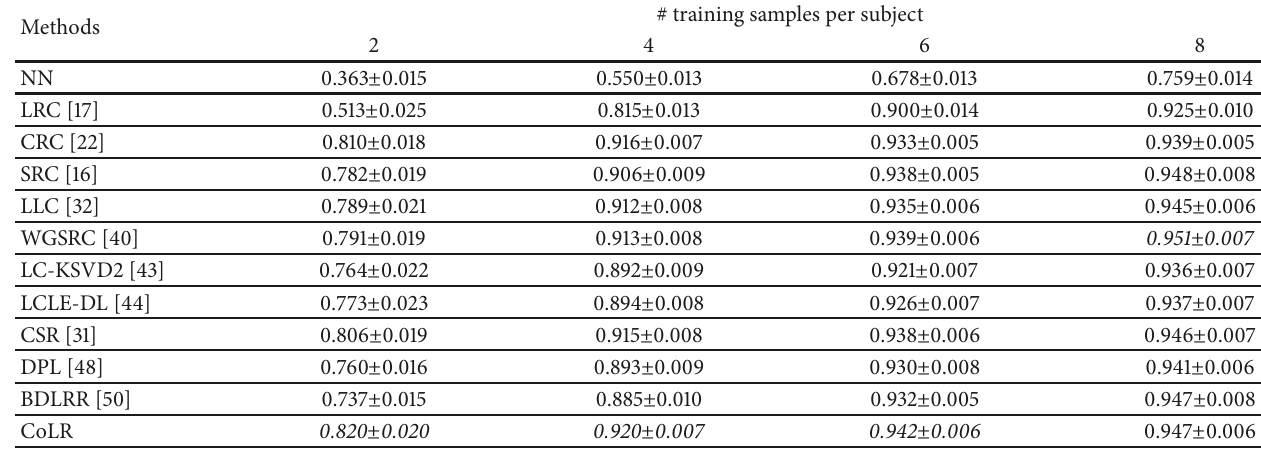
Table 7: Recognition rates on the CMU PIE dataset with different number of training samples.